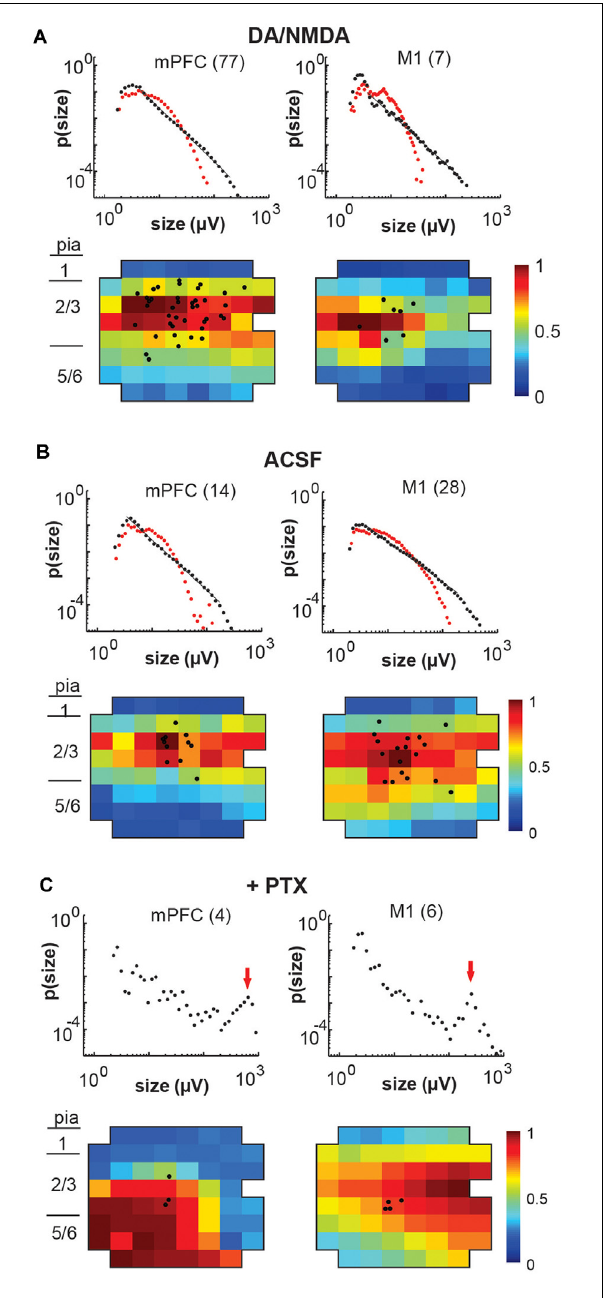
FIGURE 6 | Overview of total avalanche activity and location of whole-cell patched pyramidal neurons in layer 2/3 for all recording conditions. (A) Avalanche size distribution obtained under artificial cerebral spinal fluid (ACSF) + DA/NMDA conditions for mPFC and M1 acute slices from adult rats. Size distributions reveal power laws in line with neuronal avalanches, which are destroyed by shuffling ( red ). Numbers indicate the total number of slice experiments for each region. Bottom density plots indicate population activity measured on the MEA aligned to medial (mPFC) and dorsal (M1) border averaged over all slice experiments. Approximate layers as a visual guide indicated on the left (MEA, 8 × 8 electrodes, 200 µ m interelectrode distance, corner electrodes missing, additional ground electrode in 4th row on the right). The color indicates the activation rate (averaged over